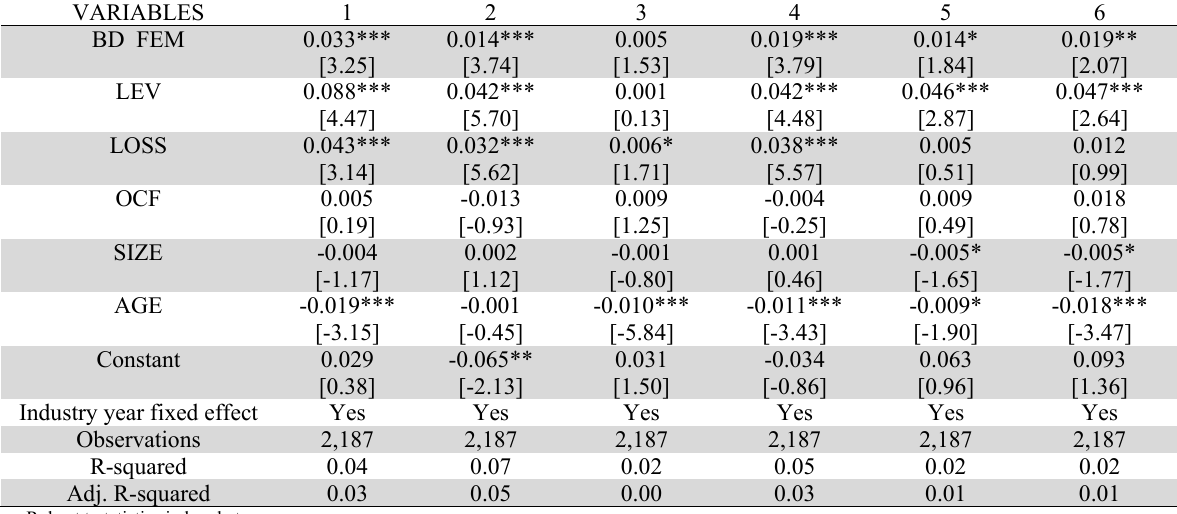
Table 5 The results of statistical